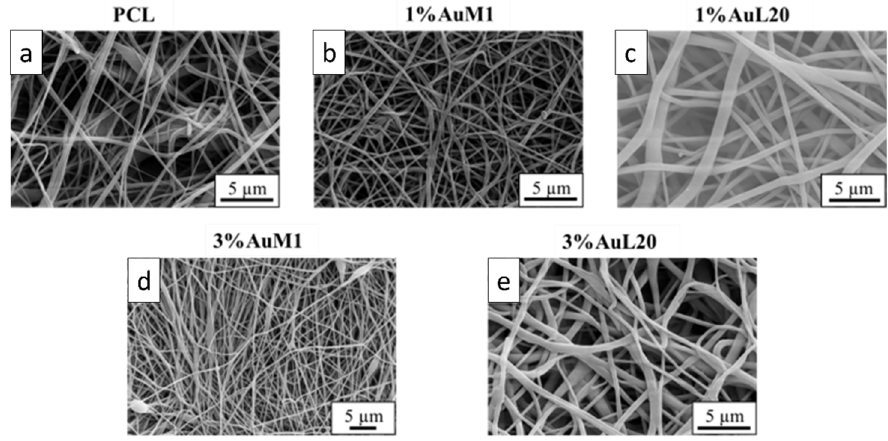
Figure 8. FESEM of the membranes: ( a ) PCL; ( b ) 1%AuM1; ( c ) 1%AuL20; ( d ) 3% AuM1; ( e ) 3%AuL20.